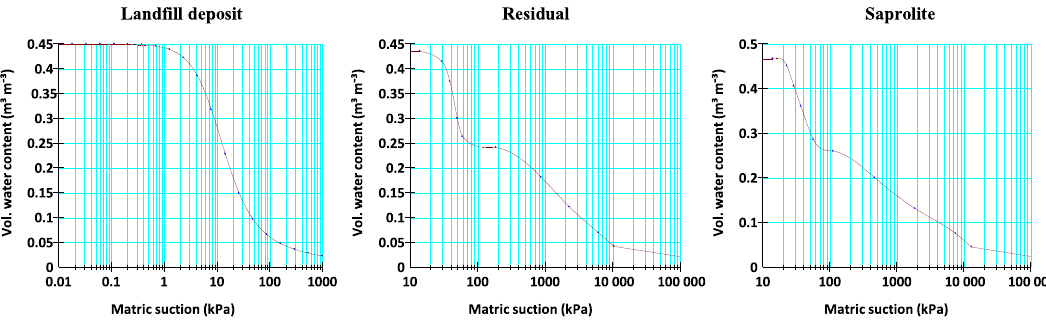
Figure 8. Water retention curves of the three soil types used in transient seepage